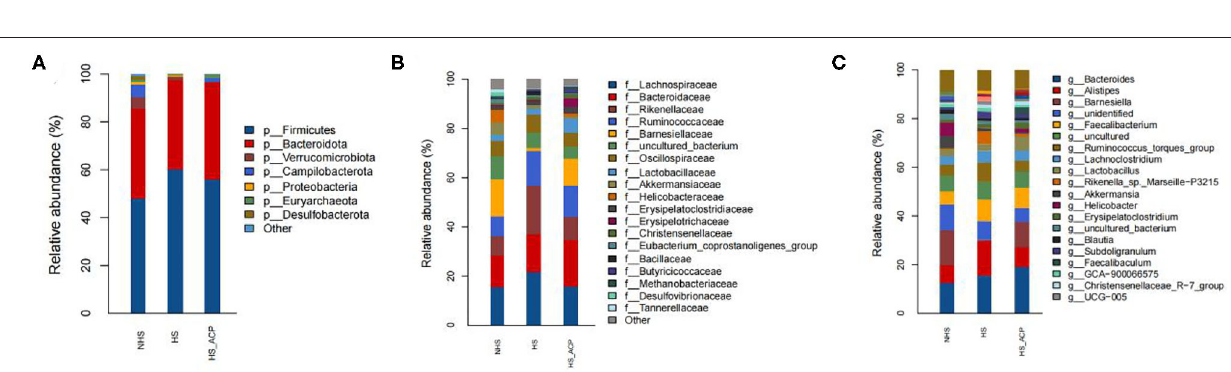
Alistipes , and the family Rikenellaceae , Bacillaceae , ( P < 0.05), and Butyricicoccaceae ( P < 0.05). In short, intestinal microbes